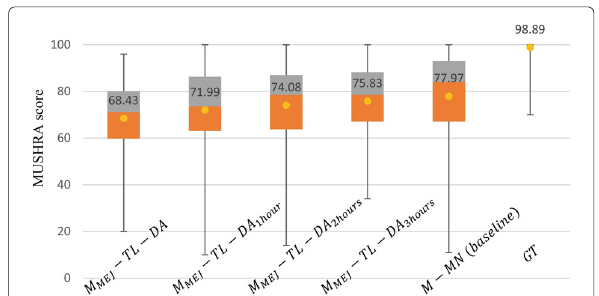
Fig. 11 MUSHRA naturalness scores for baseline and proposed multi-speaker model trained with various amounts of target language data